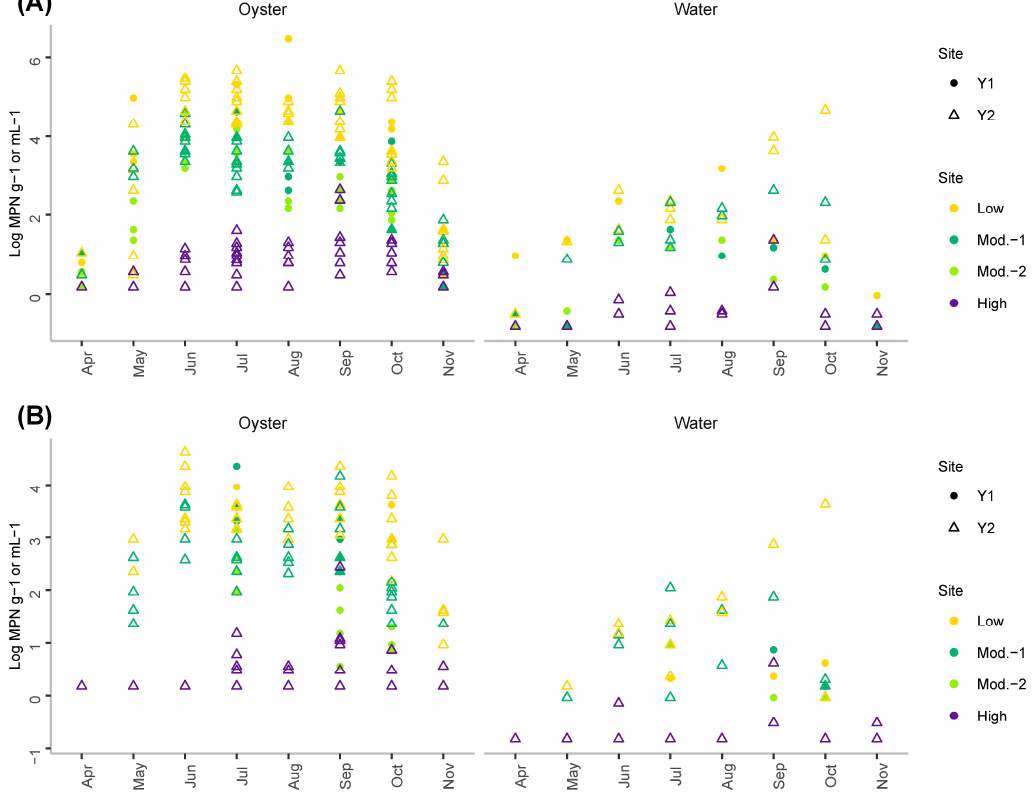
Figure 3. Concentrations of ( A ) total ( vvhA ) and ( B ) pathogenic ( pilF ) V. vulnificus measured during the study in oyster (left panel) and water samples (right panel).